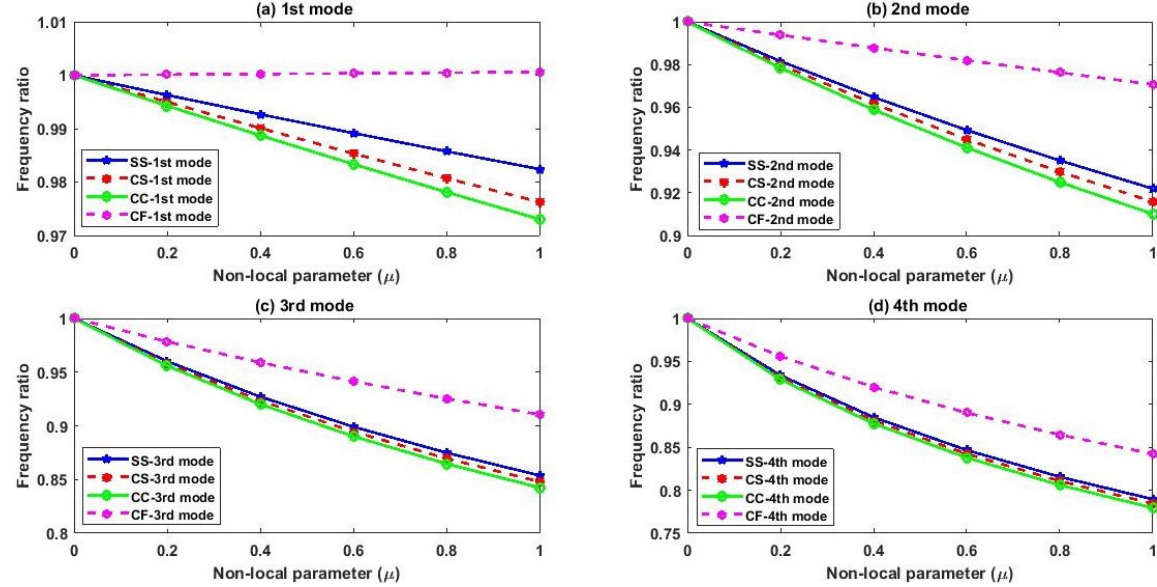
Figure 5: Variation of frequency parameter with boundary condition Table 22: Frequency parameter Winkler modulus parameter K